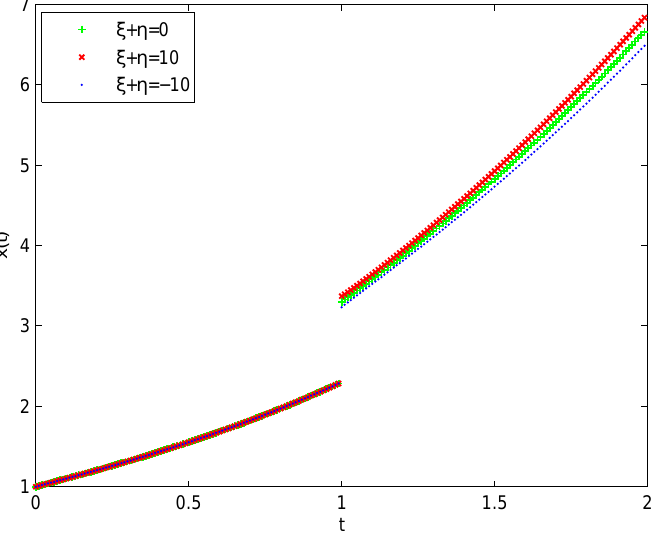
Figure 1. Three solution trajectories of